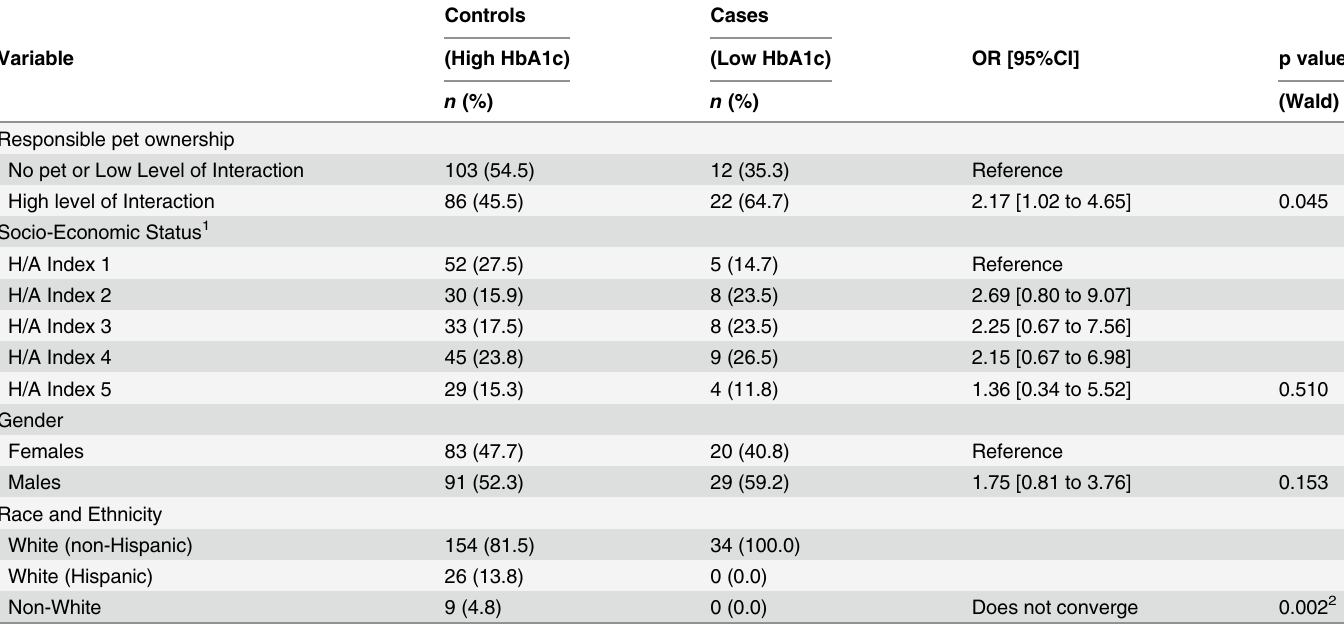
Table 2. Comparison of characteristics of patients with type 1 diabetes recruited between January 2012 and April 2013, from the Pediatrics Endo- crinology Clinic at the University of Massachusetts Medical School (Categorical